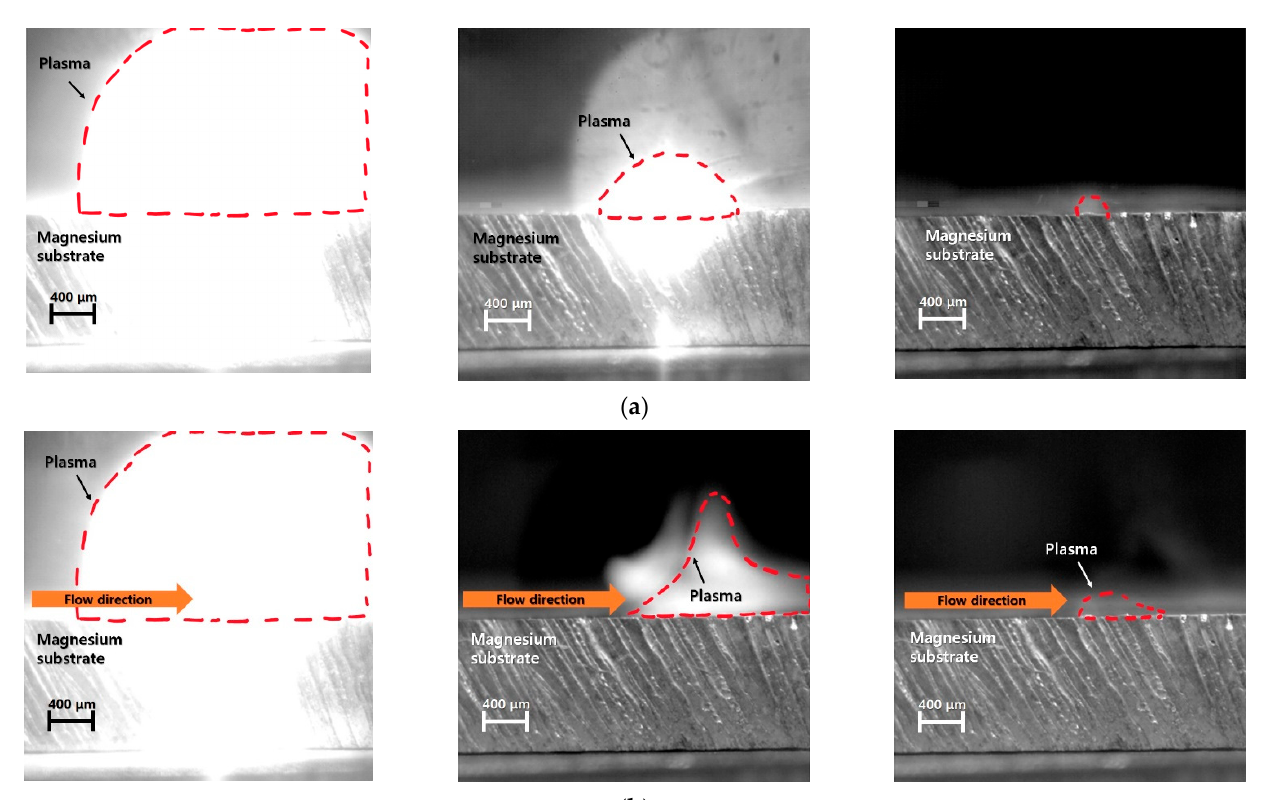
Figure 5. ( a ) Formation and extinction of plasma in the absence of gas flow. ( b ) Plasma generation and annihilation geometry when nitrogen gas flow is 350 cm 3 /s.